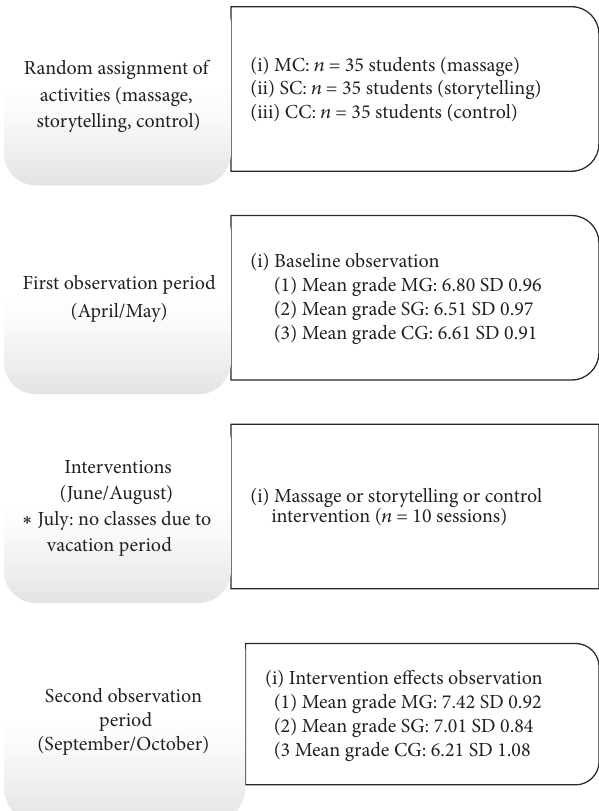
Figure 1: Research